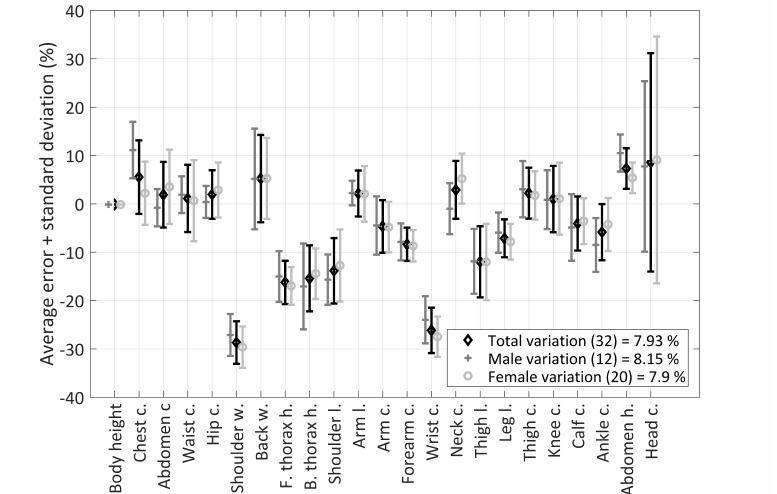
Figure 5. Czech adolescents. Average variations and the standard deviations.